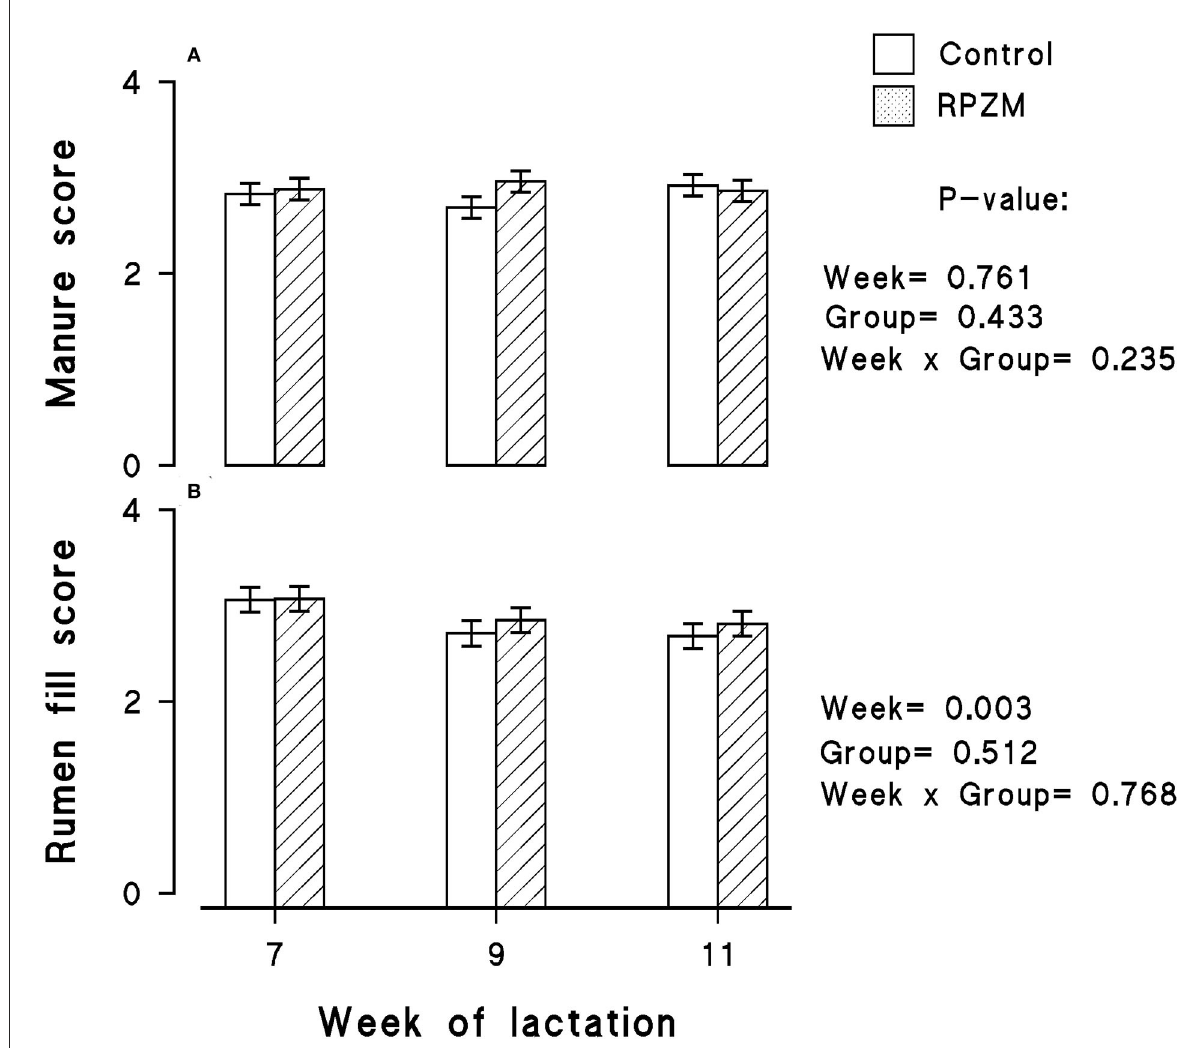
FIGURE4 Manure score (A) and rumen fill score (B) of high-producing Holstein cows supplemented without (control) or with rumen-protected zinc–methionine complex (RPZM) during long-term environmental heat stress. Values are means ± standard error of means.